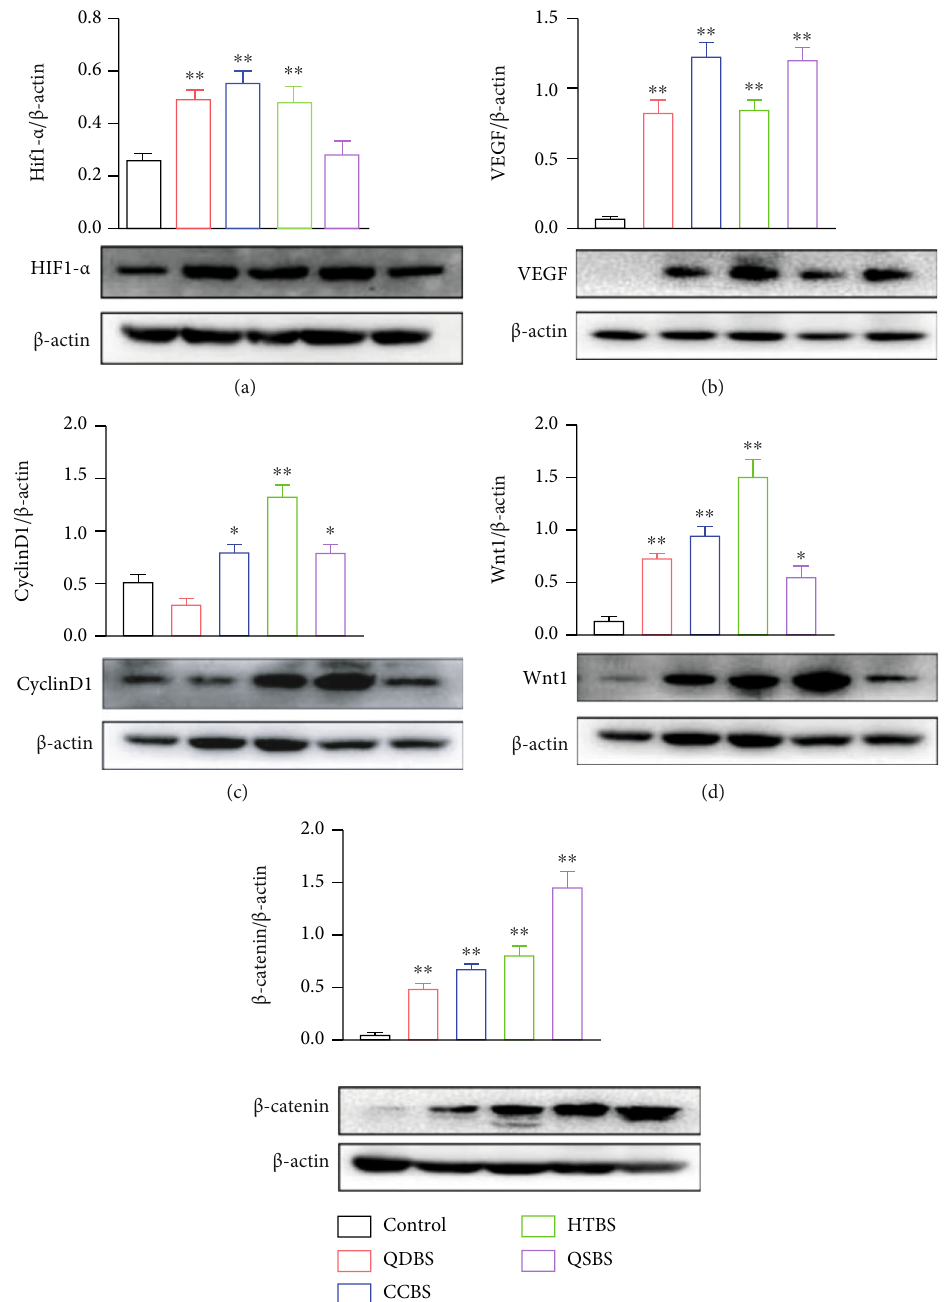
Figure 5: Expression of hypoxia-inducible factor 1-alpha (HIF-1 α ), vascular endothelial growth factor (VEGF), Cyclin D1, Wnt1, and β - catenin in tumors of the blood stasis syndrome groups. (a) Expression of HIF-1 α in tumor tissues. (b) Expression of VEGF in tumor tissues. (c) Expression of Cyclin D1 in tumor tissues. (d) Expression of Wnt1 in tumor tissues. (e) Expression of β -catenin in tumor tissues. ∗ P < 0 : 05 , ∗∗ P < 0 : 01 , and ∗∗∗ P < 0 : 001 , vs.